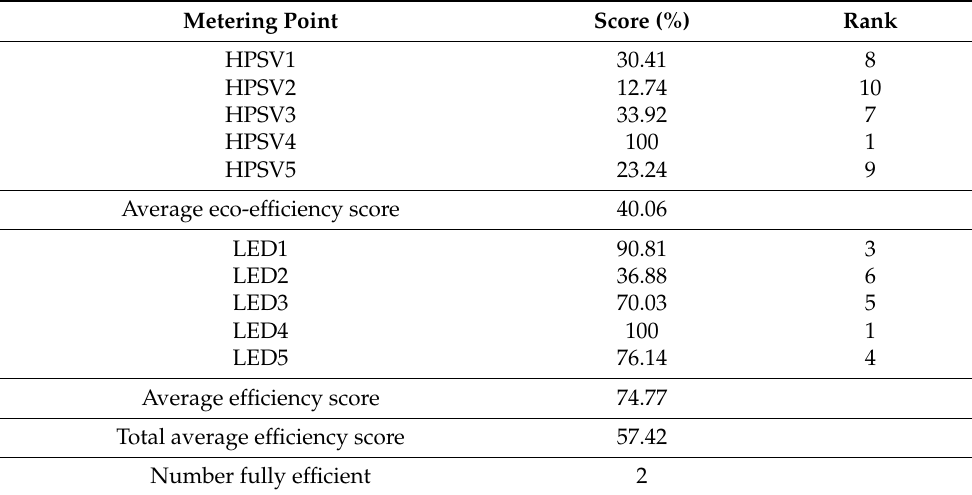
Table 9. Results of the DEA eco-efficiency score and rank for HPSV and LED Road